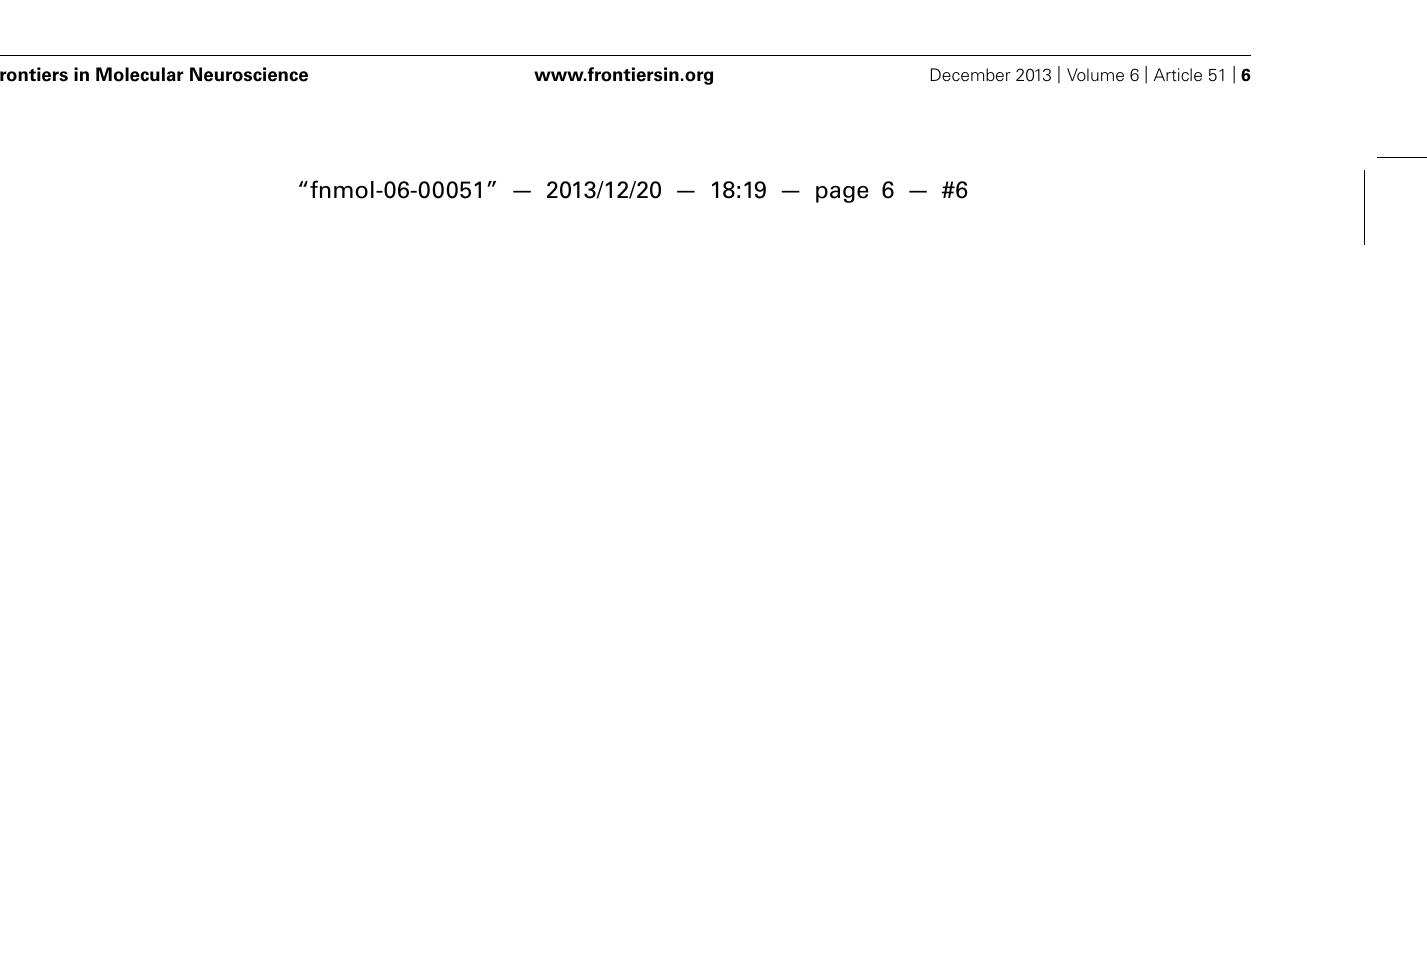
FIGURE 3 | miR-279 regulates the circadian rhythm in Drosophila. (A) Schematic showing the molecular mechanisms of central clock neurons to downstream neurons in order to regulate the rest/activity cycle.The central clock neurons release PDF which is sensed via the pdf receptor in target cells. Upon PDF receptor activation, the expression of the cytokine Unpaired is activated, but also repressed via the microRNA miR-279 .The released cytokine is bound by the receptor DOME in central clock downstream